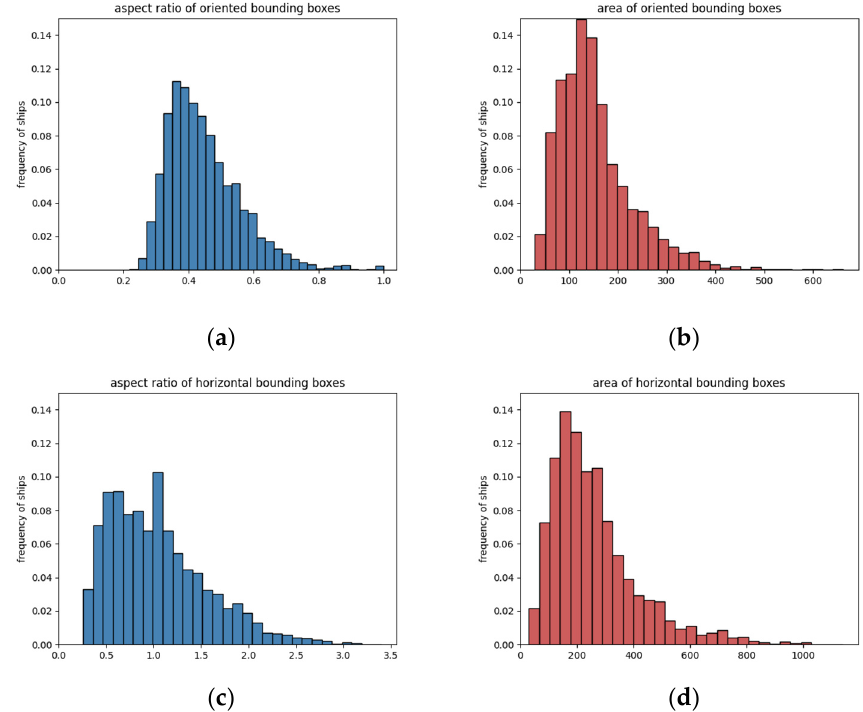
color enhancement did not actually change pixels’ grayscale but rather changed the color, which also retained the complete skeleton of the ship. In Figure 8h,i,k,l, the pixels of land and ship had similar brightness, especially in Figure 8i the object on the right side almost blended into the land. But in Figure 8g,j, the reflection brightness of the coarse land surface Figure 7. Statistical histograms of RBoxes and BBoxes in DSSDD. ( a , b ) illustrate the aspect ratio and was suppressed, and the silhouette of the hulls was more prominent. Merging different area distribution of RBoxes; ( c , d ) illustrate the aspect ratio and area distribution of BBoxes. polarization patterns can relieve detrimental interference without spoiling ship bodies. Compared with existing SAR ship datasets quantified to grayscale, our pseudo-color